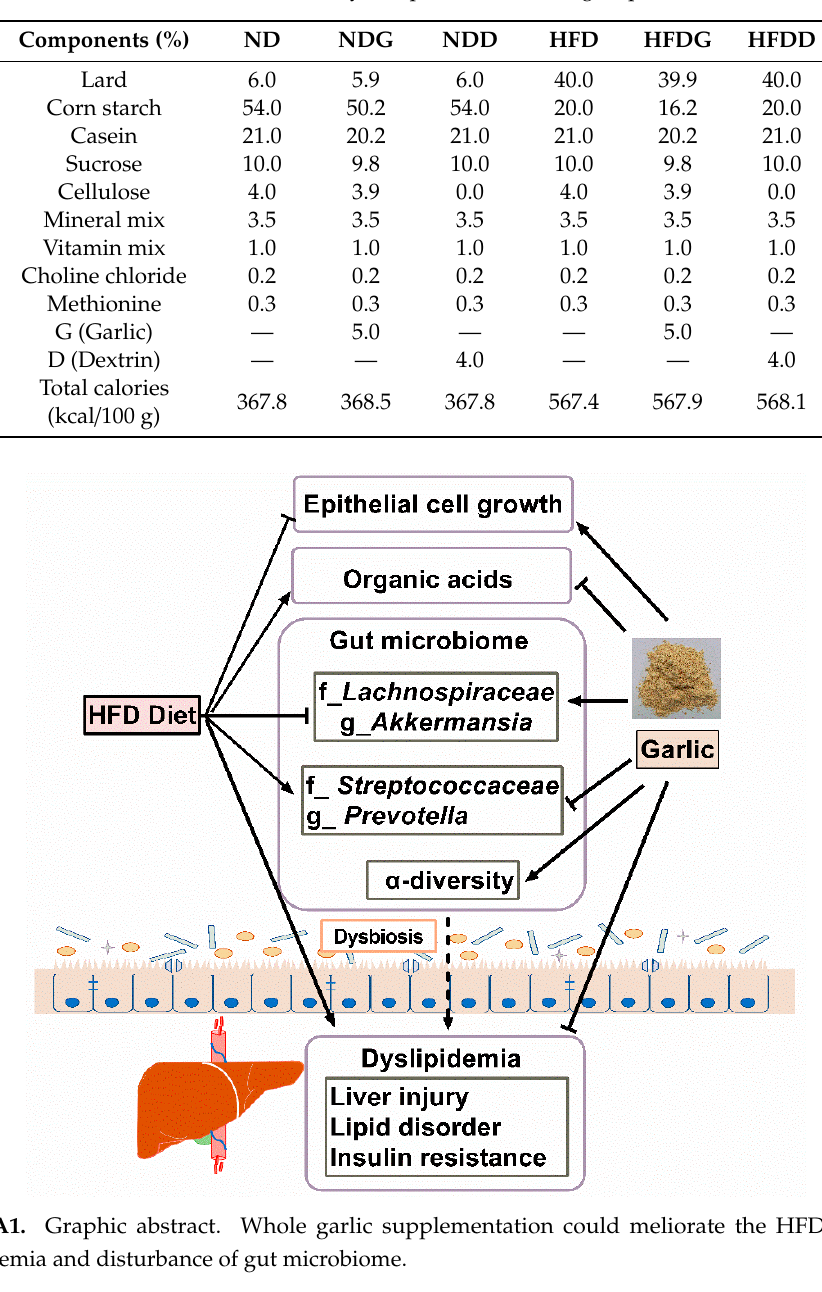
Table A2. Dietary compositions of each group.